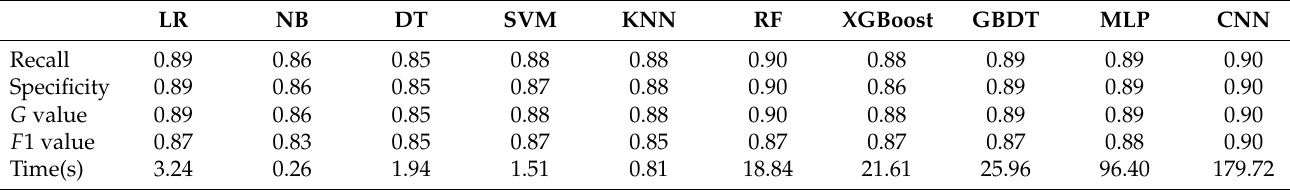
Table 12. Evaluation measures of each machine learning model in the normal and pathological voice class-balanced SVD dataset.